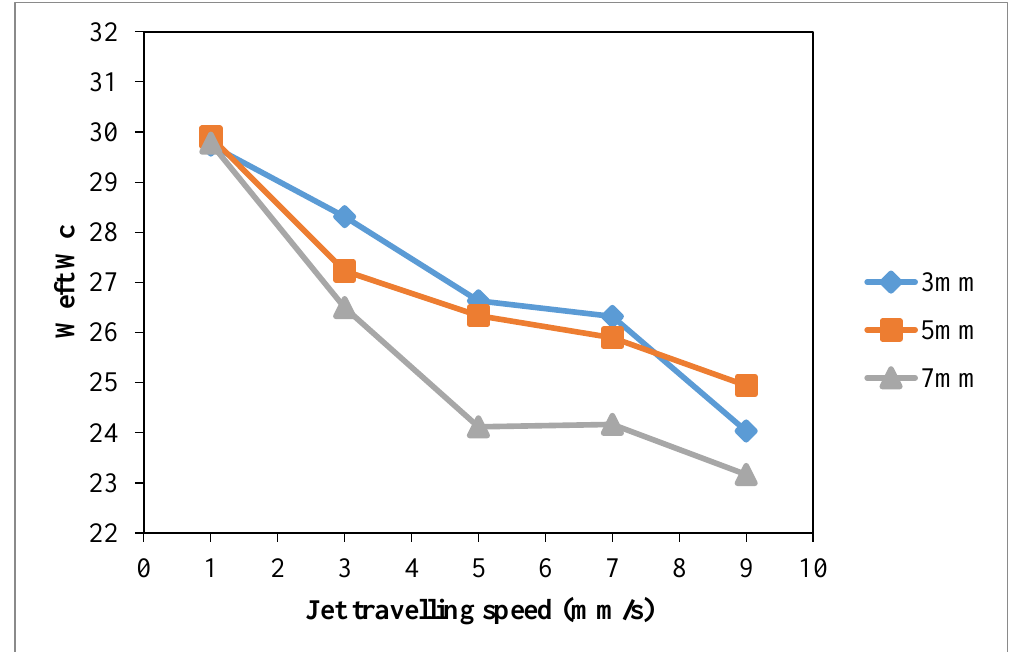
Figure 11. Effect of jet travelling speed on weft W c (Jet travelling speed: 1 mm/s, 3 mm/s, 5 mm/s, 7 mm/s and 9 mm/s; Jet-to-substrate distances: 3 mm, 5 mm and 7 mm; Discharge power: 150 W and Oxygen flow rate: 0.4 L/min).